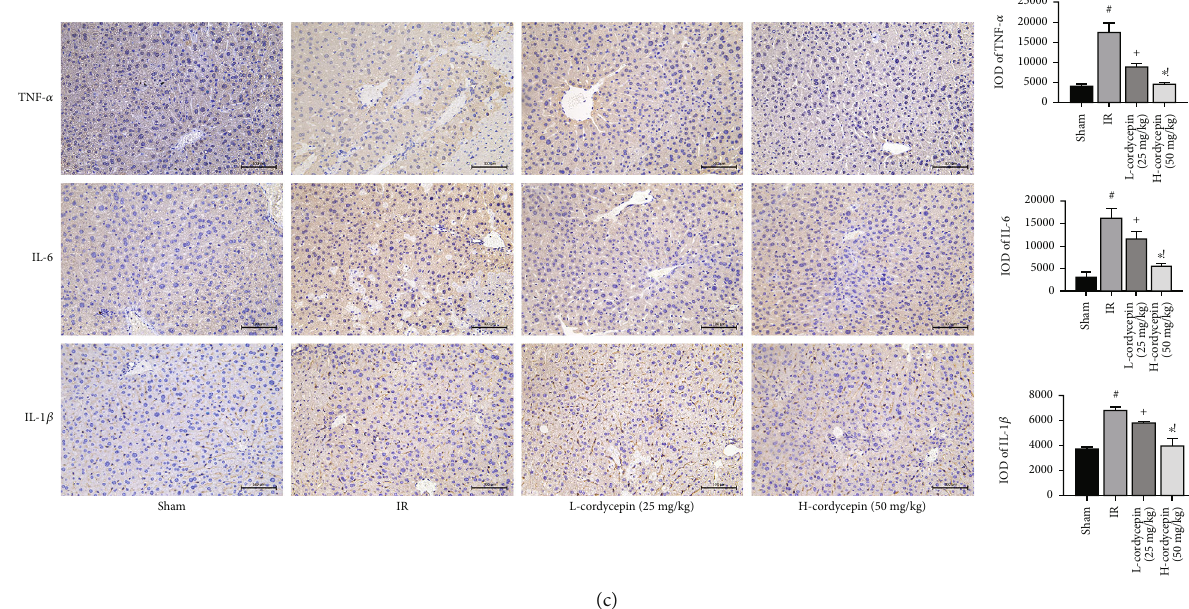
Figure 3: Cordycepin reduced systemic in fl ammatory responses induced by hepatic IR. Note: (a) western blot analysis of TNF- α , IL-6, and IL-1 β protein levels. (b) Relative TNF- α , IL-6, and IL-1 β levels were determined by qRT-PCR. (c) TNF- α , IL-6, and IL-1 β protein expressions in liver tissues after reperfusion are shown by immunohistochemical staining ( × 200). The evaluations were made by the Image-Pro Plus 6.0 software to calculate the IOD of the positive staining area. Data are presented as mean ± SD ( n = 6 ; # p < 0 : 05 for IR vs. sham; + p < 0 : 05 for L-cordycepin (25mg/kg) vs. IR; ∗ p < 0 : 05 for H-cordycepin (50mg/kg) vs. IR; ! p < 0 : 05 for L-cordycepin (25mg/kg) vs. H-cordycepin